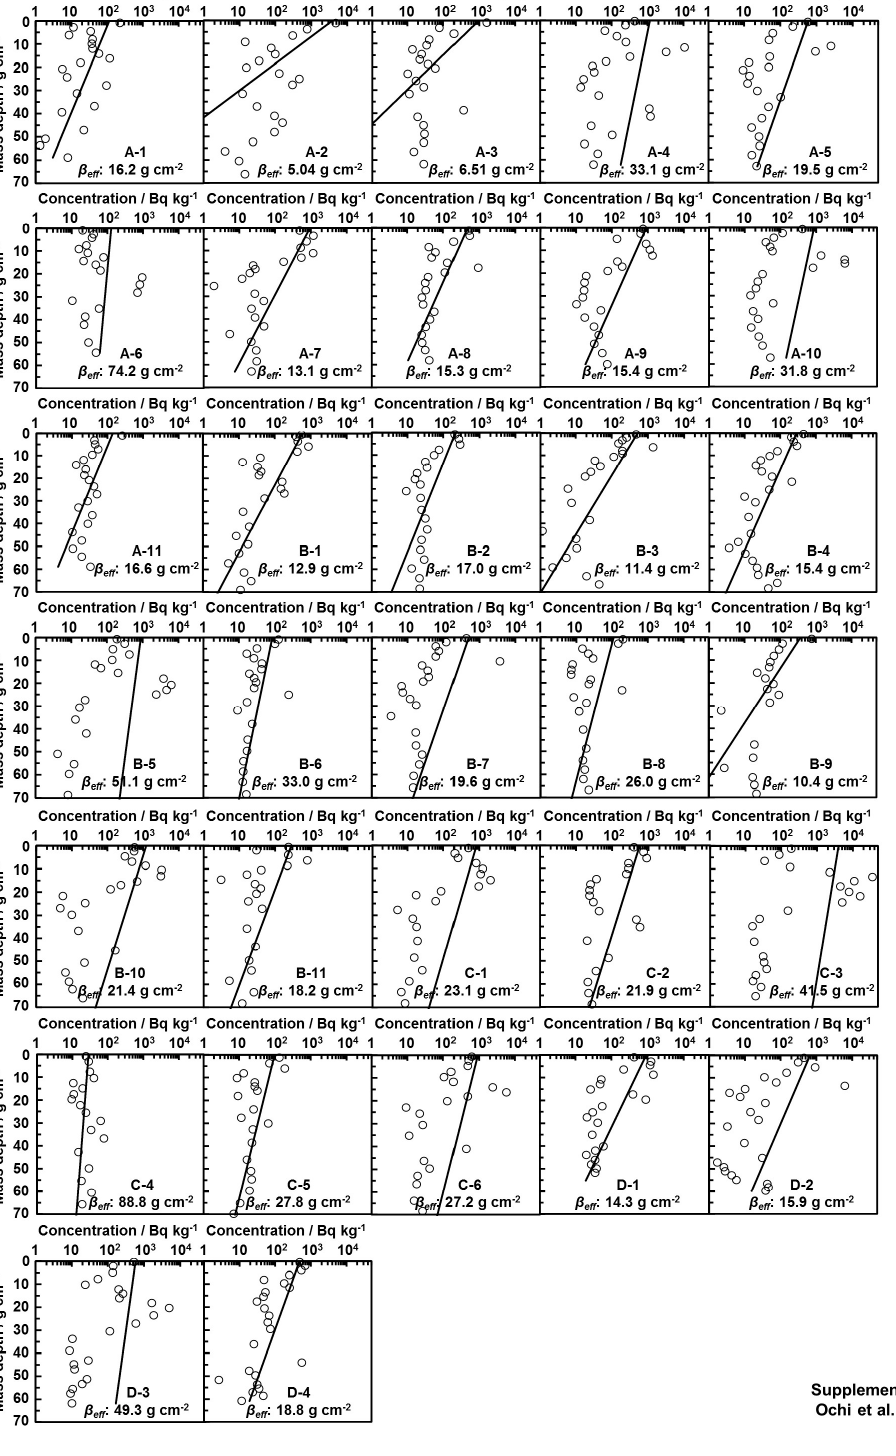
Figure A1. All vertical distributions of radiocesium are shown in the appendix ( n = 32).